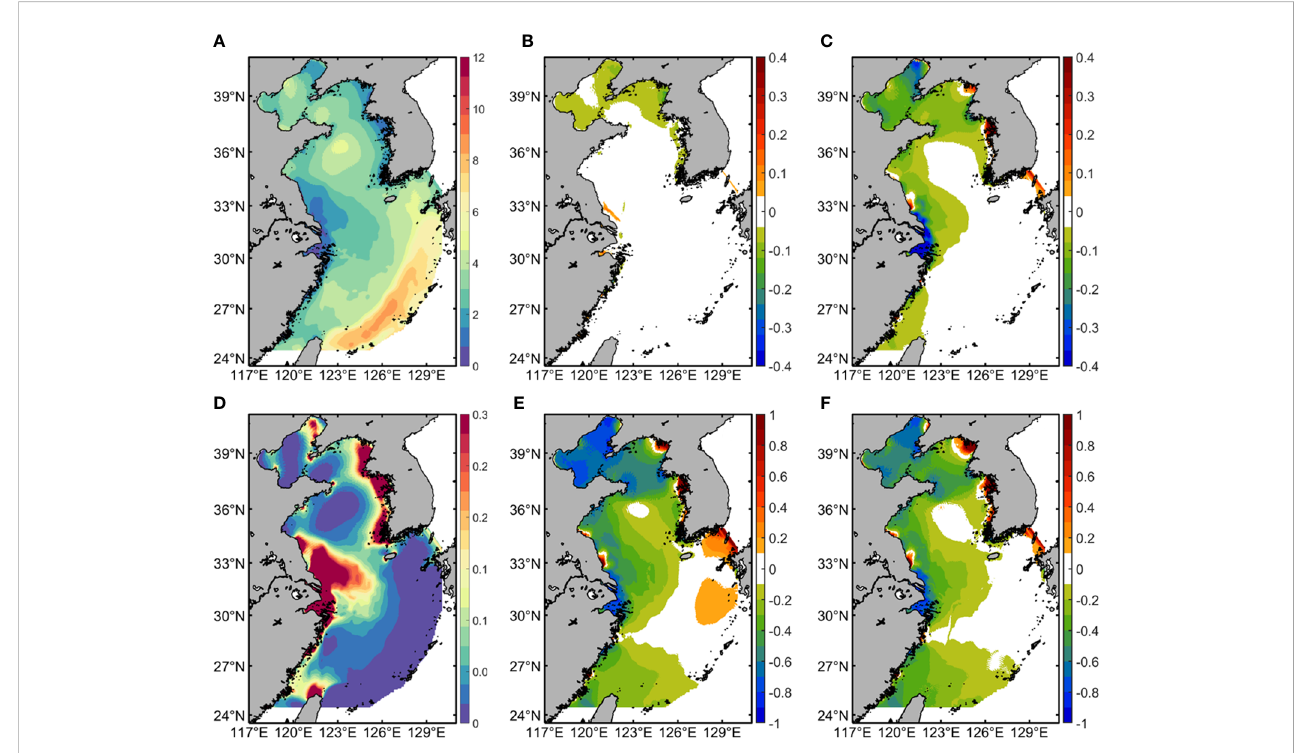
FIGURE 12 (A) Estimations of Simpson-Hunter (SH) number in EXP 3. (B, C) Relative differences of SH numbers between EXP 1, EXP 2 to EXP 3, respectively. (D) The cubed time-averaged and depth-averaged current velocity ( u 3 ) in EXP 3. (E, F) Relative differences of depth-averaged current velocity between EXP 1, EXP 2 to EXP 3,